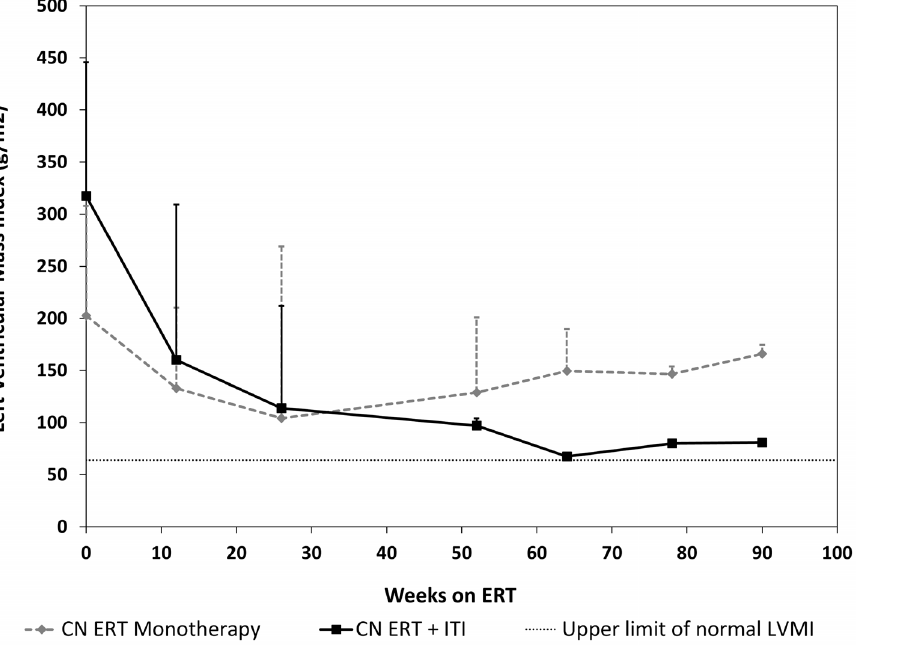
Figure 4. Comparison of median left ventricular mass index (LVMI) values seen over time in CRIM-negative (CN) ERT monotherapy (n=11) versus CN ERT + ITI (n=7) treated patients. The upper limit of normal LVMI is 64 g/m 2 (represented by a horizontal dashed